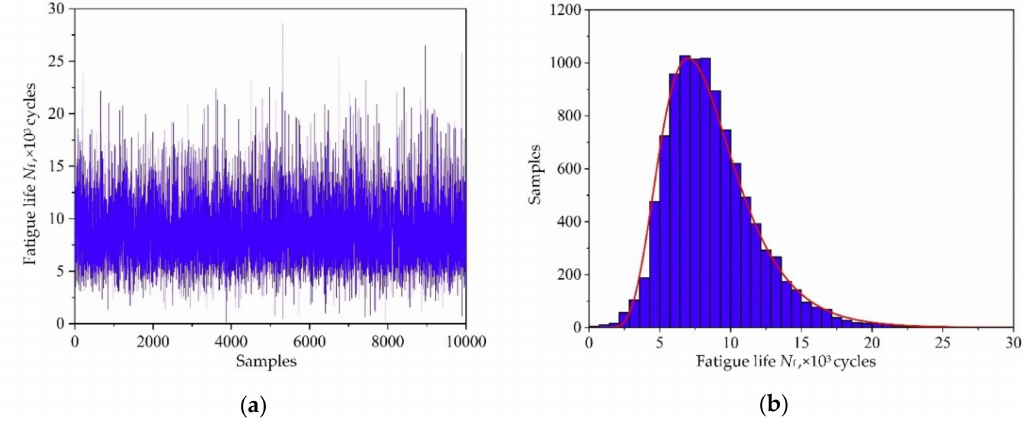
Figure 19. Fatigue life of turbine rotor: ( a ) simulation history, ( b ) probabilistic